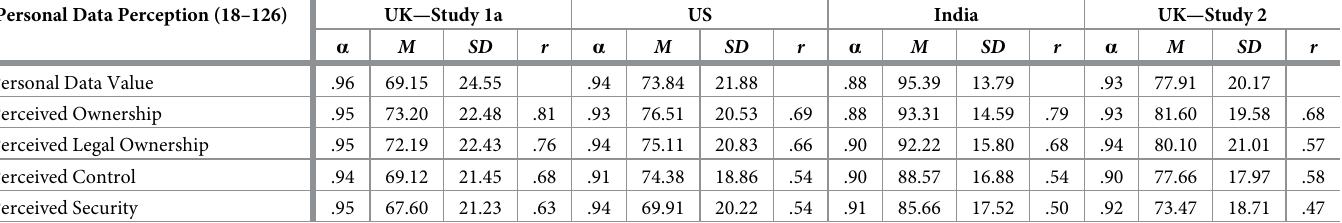
Table 1. Cronbach’s alpha, mean, standard deviation and correlation with value for the 5 personal data perceptions across UK (Studies 1a & 2) and USA and India (Study 1b). Personal Data Perception